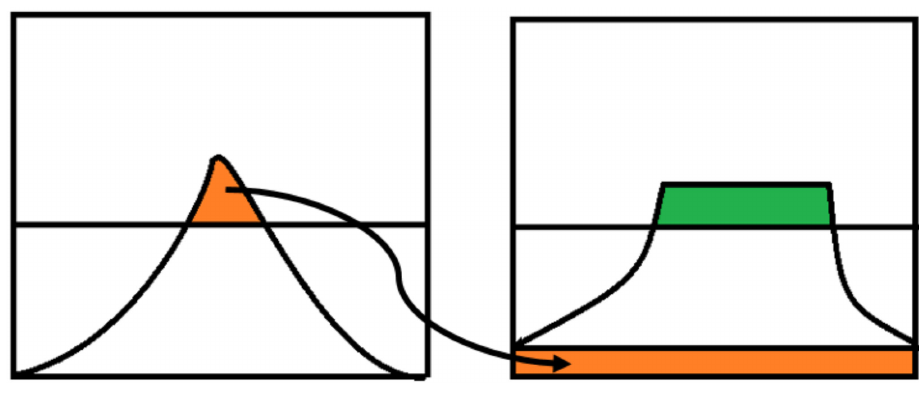
Figure 7. CLAHE concept.